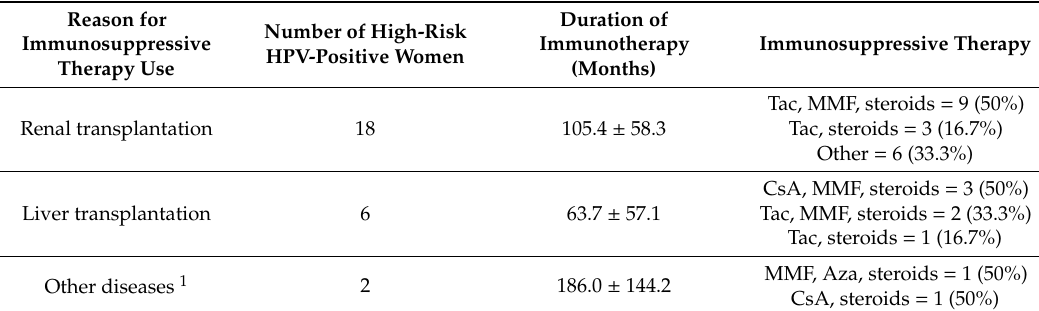
Table 4. High- risk HPV-positive patients’